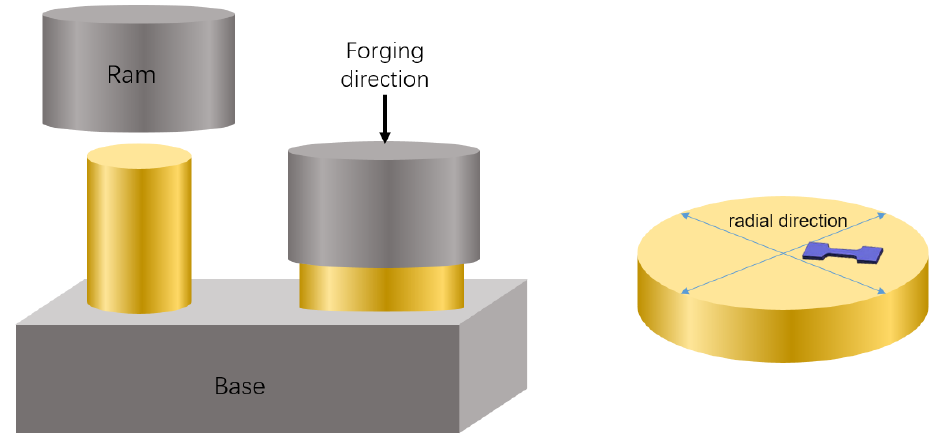
Figure 1. A schematic diagram showing the HERF process, and a tensile specimen cut from the forged disc.